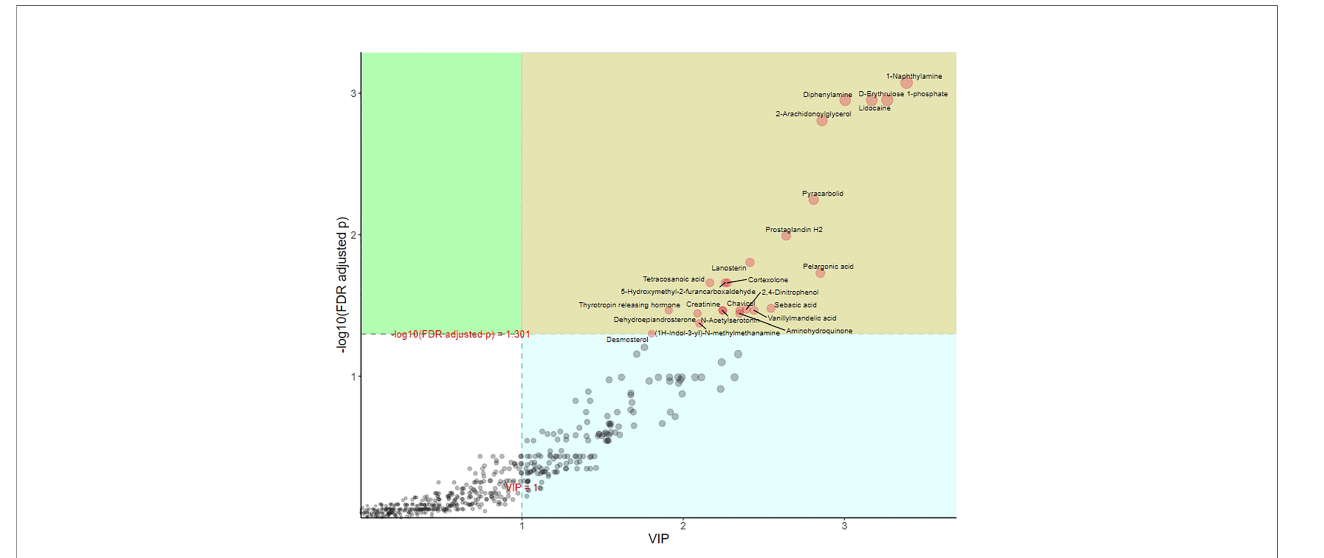
FIGURE 6 | OPLS-DA metabolite importance map of group of POR and controls. Each point represents a metabolite. The abscissa is VIP, and the ordinate is the p value after FDR correction (log10 transformation).